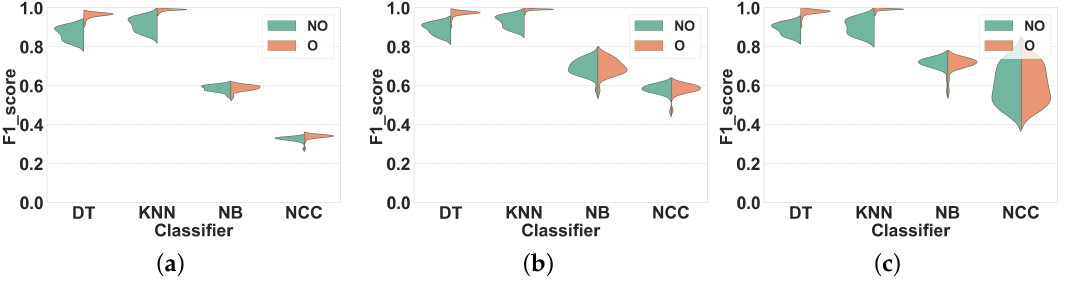
Figure 5. Experiment 1–Subject-dependent CV–Dataset 1. ( a ) FS1; ( b ) FS2; ( c ) FS3.